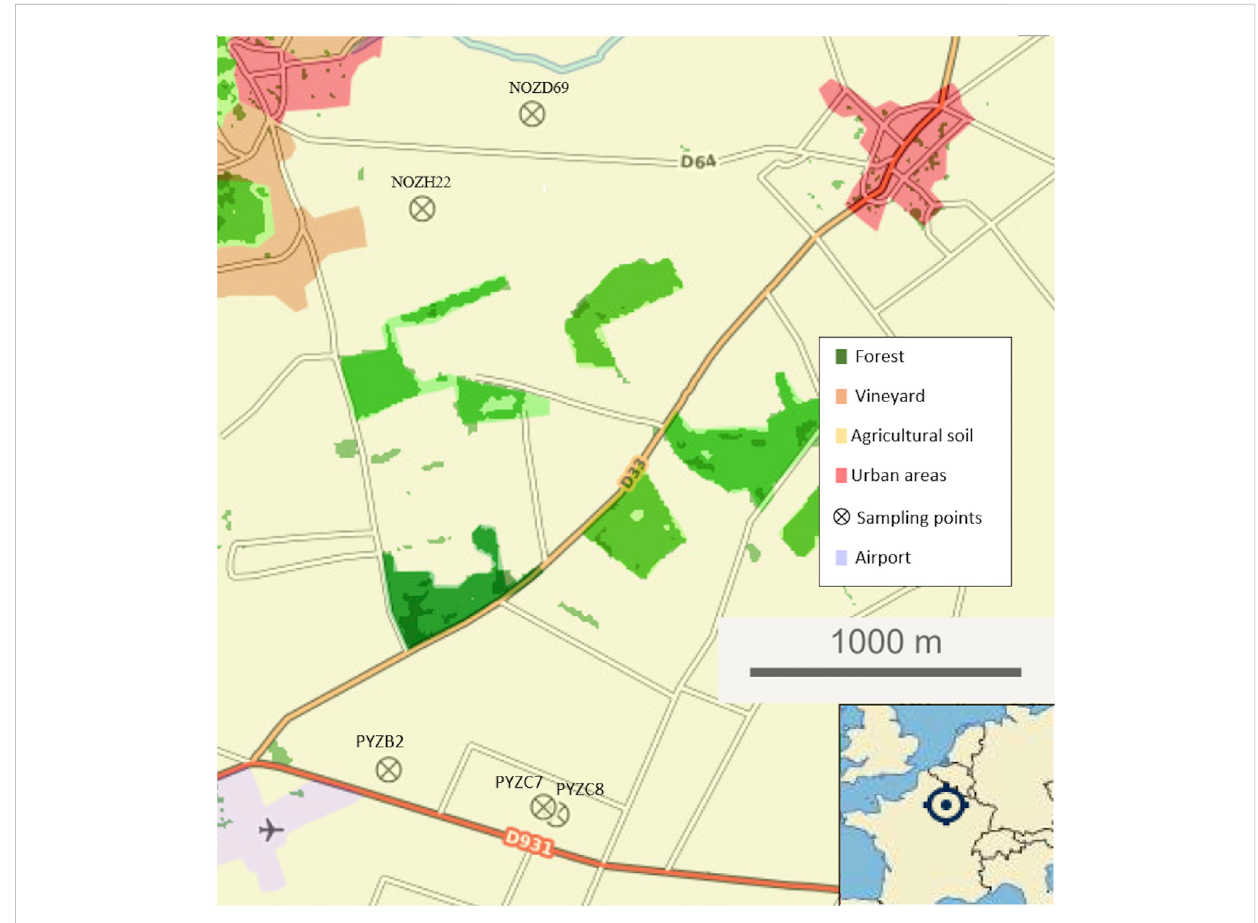
FIGURE 1 Sample locations: the fi ve soil samples are represented by a circled cross (© IGN